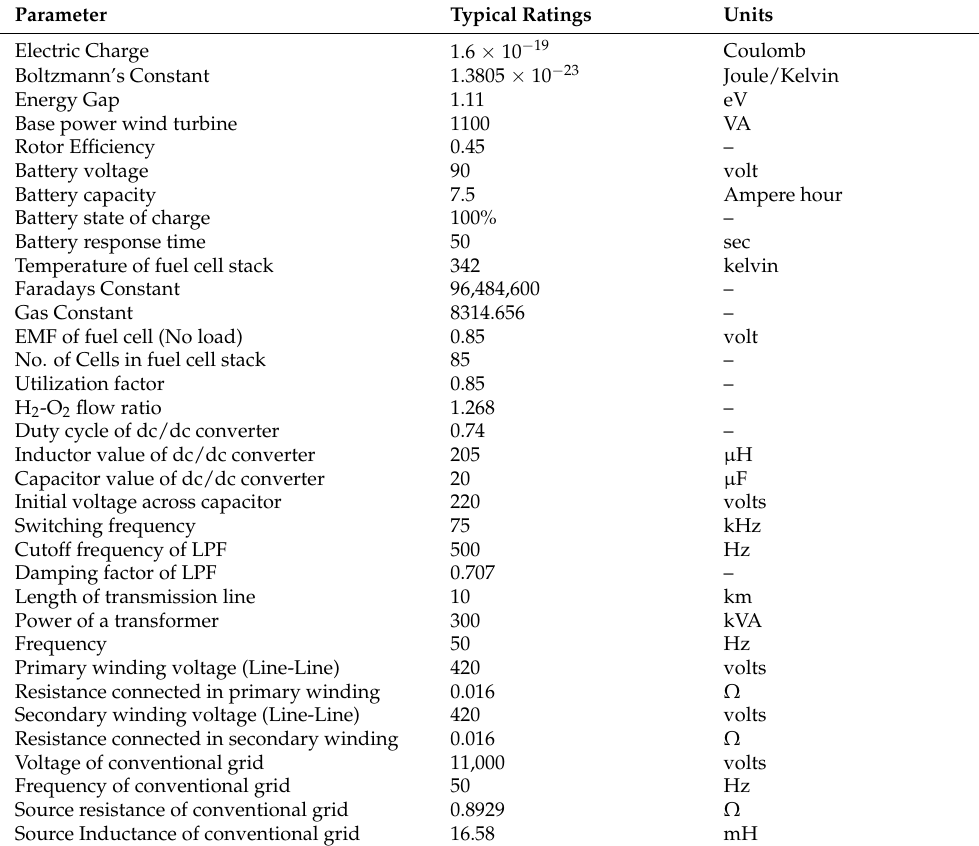
Table 1. Typical values of components used in the proposed system